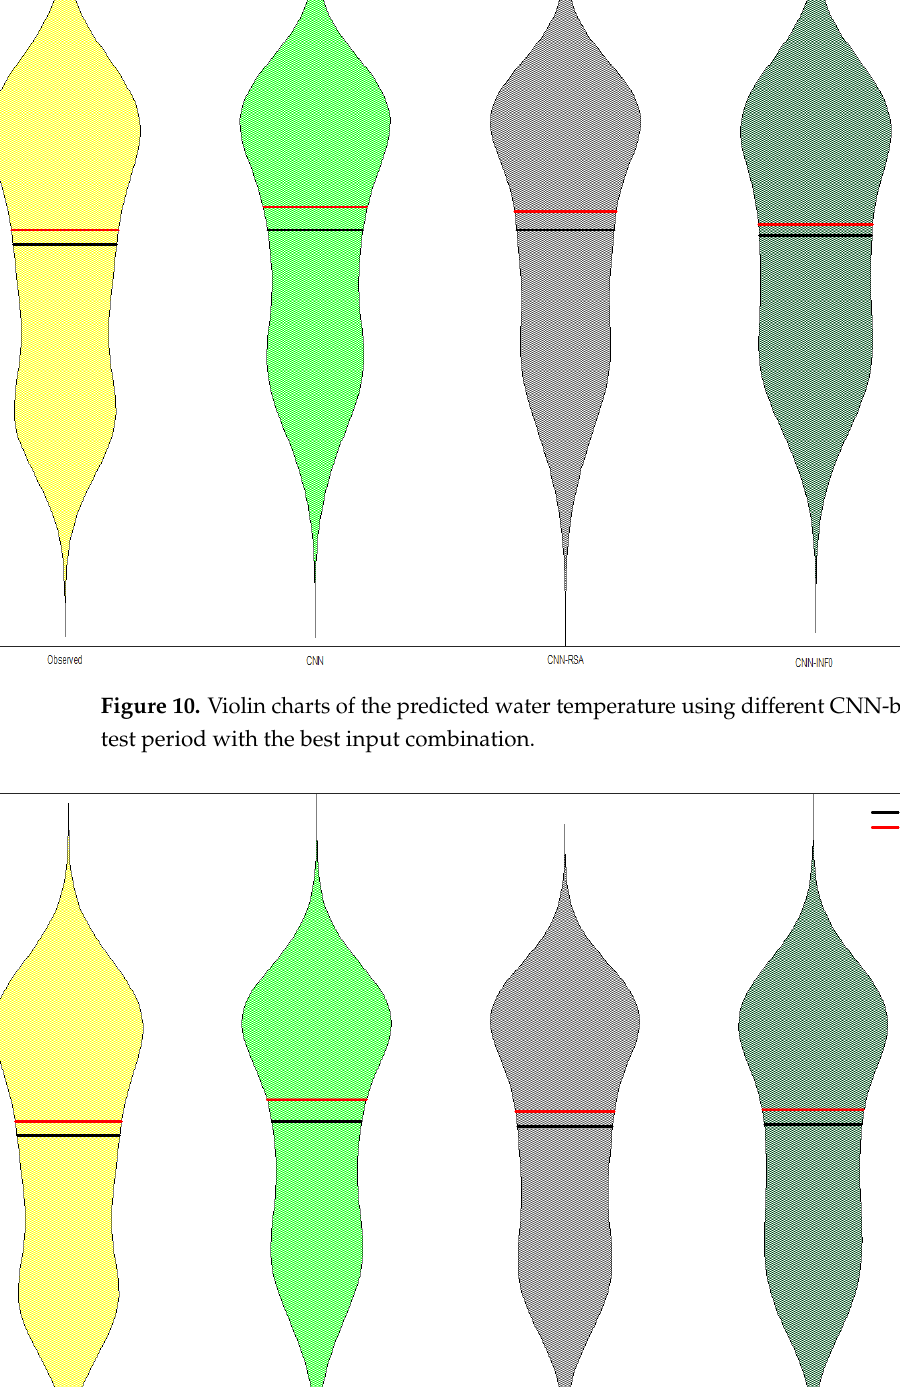
Figure 11. Violin charts of the predicted water temperature using different LSTM-based models in the test period with the best input